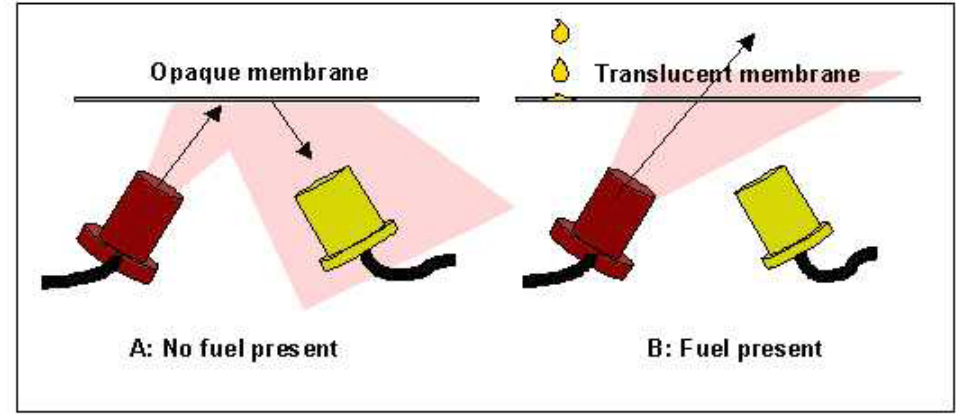
FIGURE 2. ( A) Opaque membrane provides high reflectance and a low signal; (B) Absorbed fuel results in a translucent membrane, which results in low reflectance and high